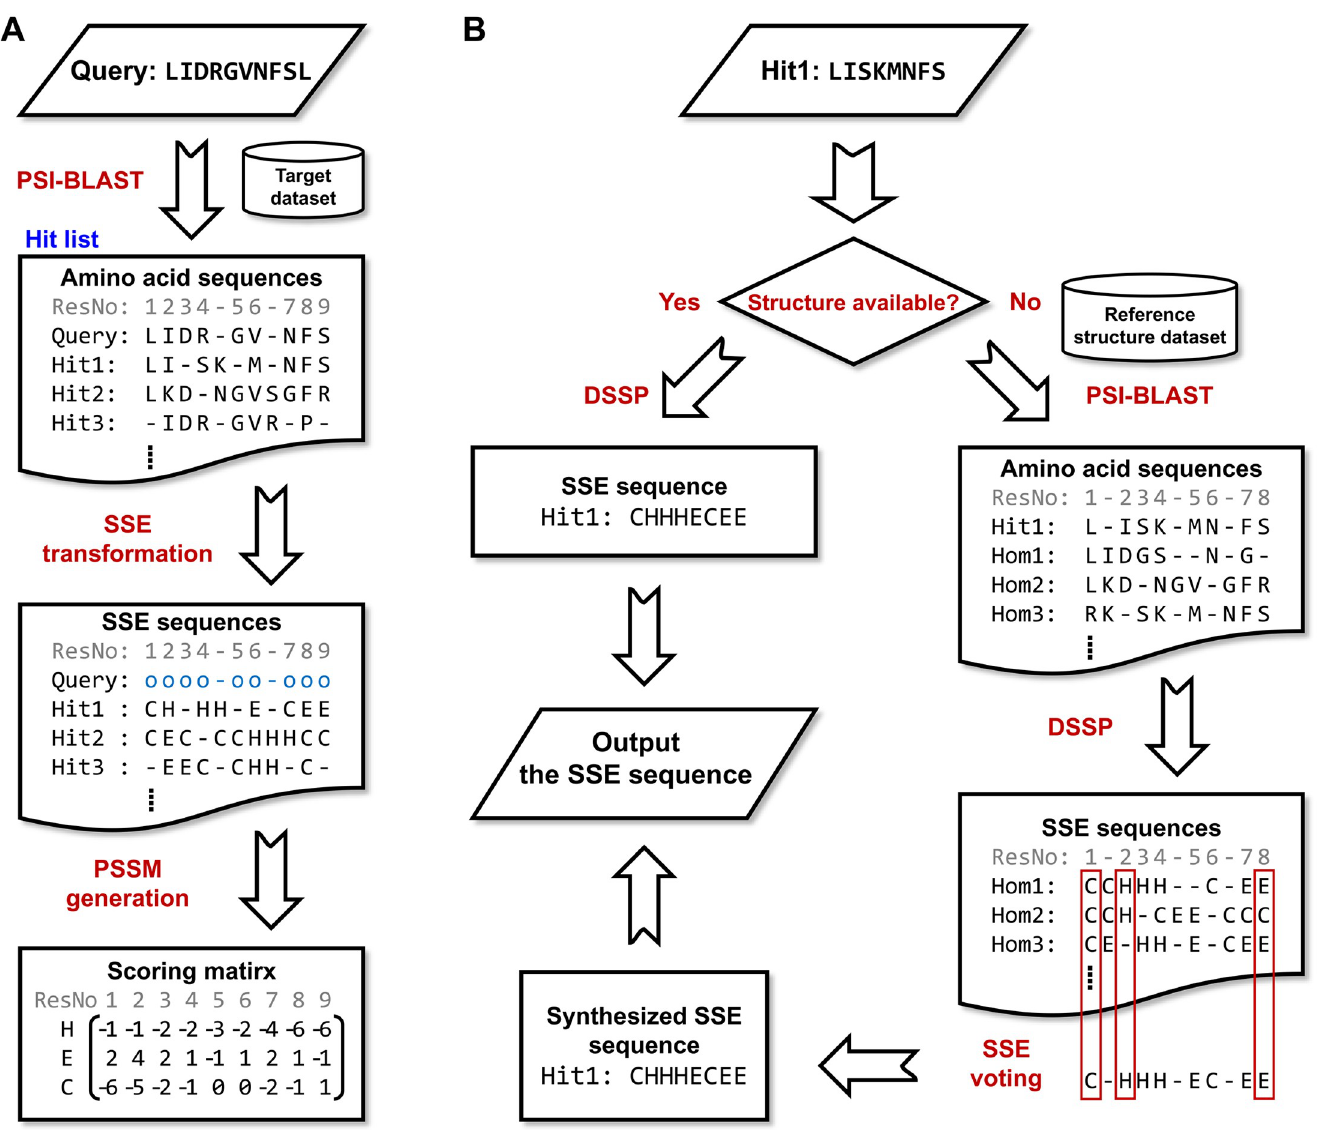
Fig 4. Flowchart of the SSE-PSSM algorithm. (A) The core procedure of the algorithm. (B) Determination of the SSE sequence of a hit. A sequence similarity search is performed to retrieve a hit list for the query sequence. Next, for each hit protein, directly obtain its SSE sequence from the known structure or synthesize one by position-specific voting according to the homologs (Hom) of the hit retrieved by the second-round sequence similarity search against a reference protein structure dataset. An SSE transformation of the sequence alignments between the query and hits is then carried out by replacing the amino acids with SSE codes. Finally, the PSSM is generated according to the transformed